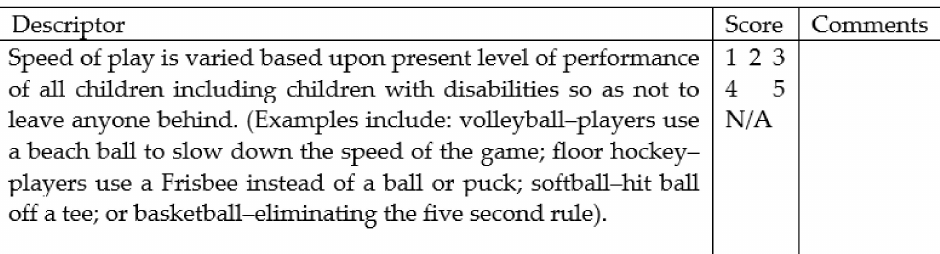
Figure 1. Original LIRSPE item 4